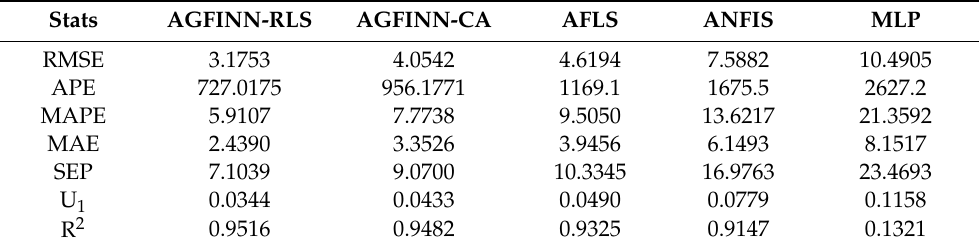
Table 2. Statistical performance for electricity price forecasting models at 04:00—case study